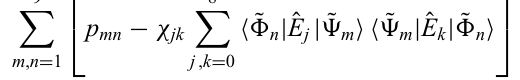
(cid:2) and | ψ S (cid:2) , with a theoretical value of 0. (c) The 0 1